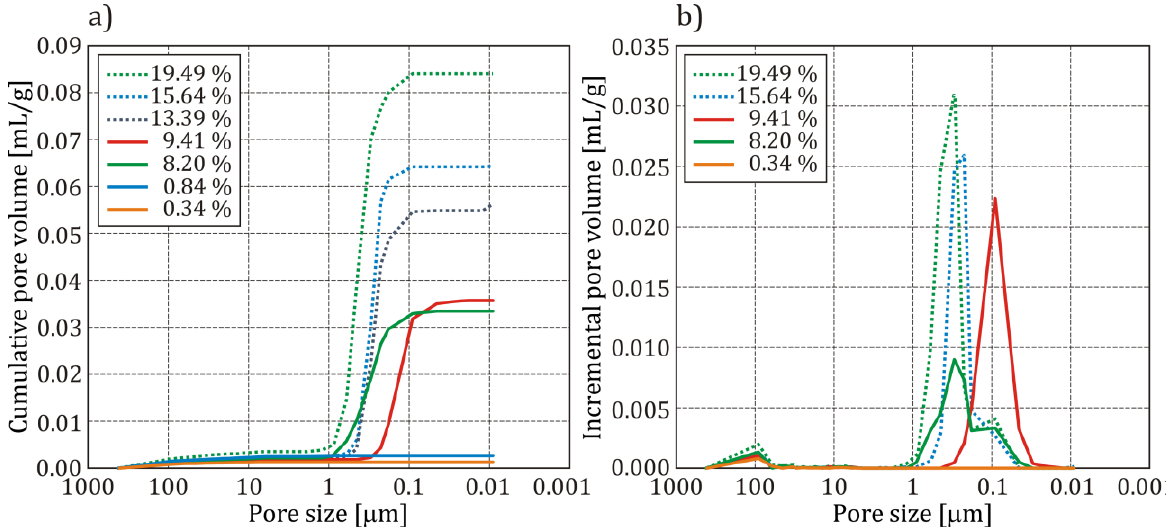
Figure 2. Cumulative pore volume ( a ) and incremental pore volume ( b ) vs. pore size curves for samples of different po- rosity and pore distribution, G-5 borehole.